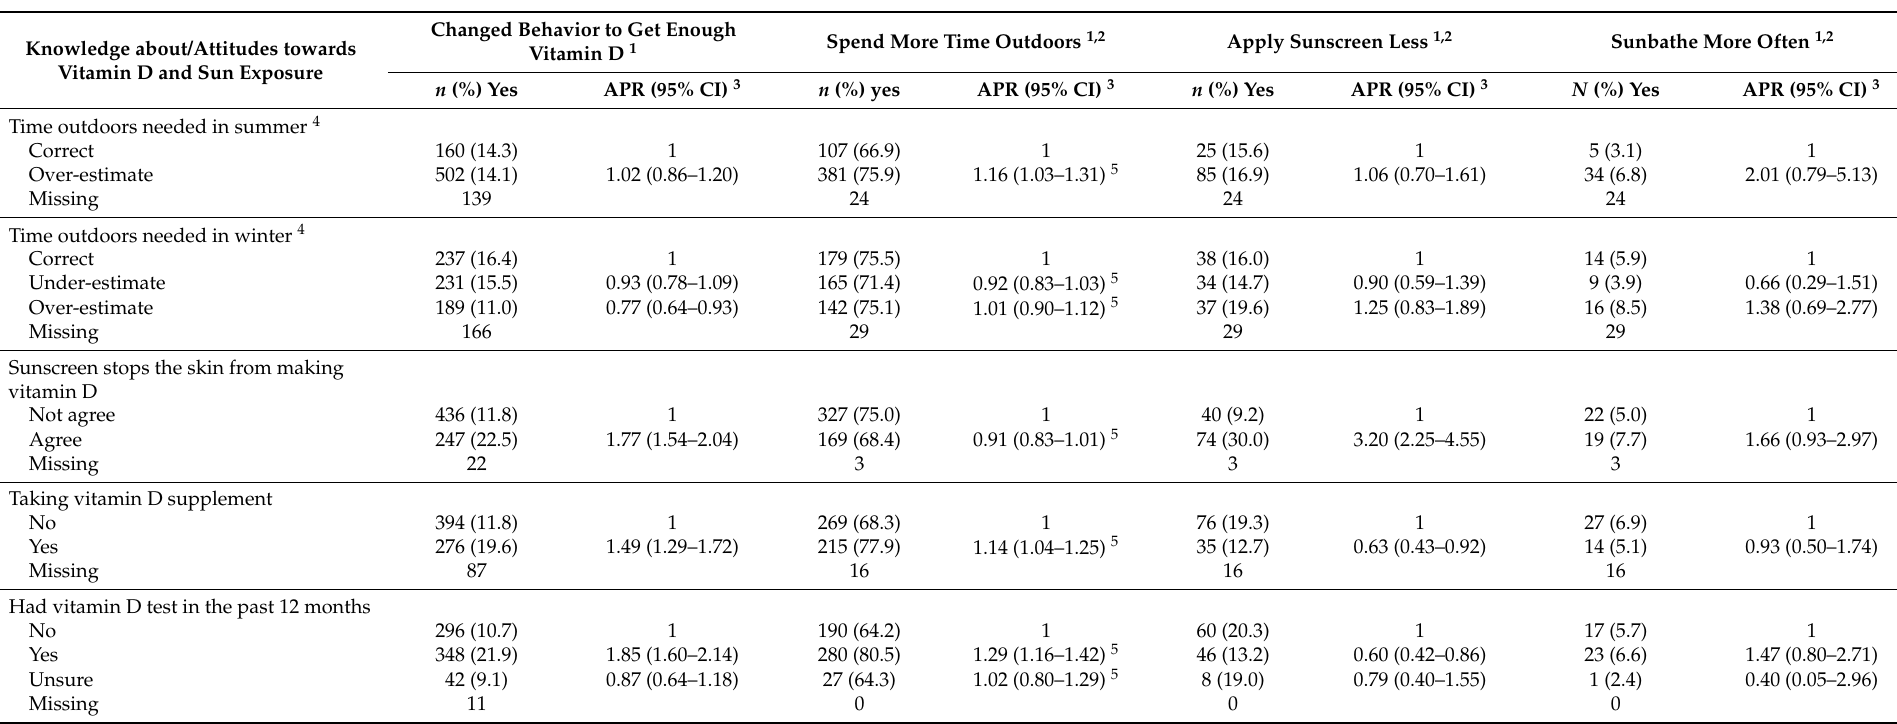
Table 5. Associations between knowledge about/attitudes towards vitamin D/sun exposure and changing behaviors to get enough vitamin